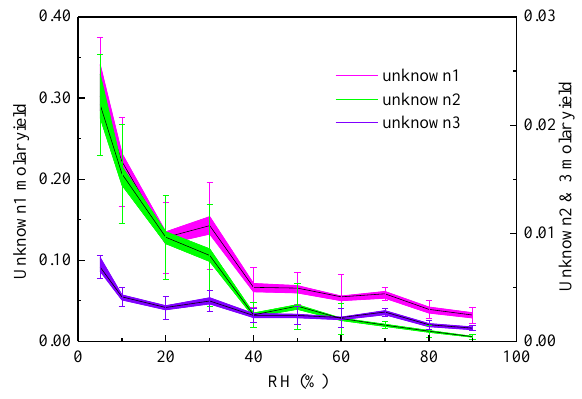
Fig. 4. Dependence of the product molar yields for the unknown peroxides on relative humidity (RH). The upper edge of the filled area represents the corrected unknown peroxide yields using the wall loss curve of HMHP. The lower edge of the filled area rep- resents the corrected unknown peroxide yields using the wall loss curve of H 2 O 2 . The black line represents the mean value, and the error bar represents 2 σ of the detected concentrations of unknown